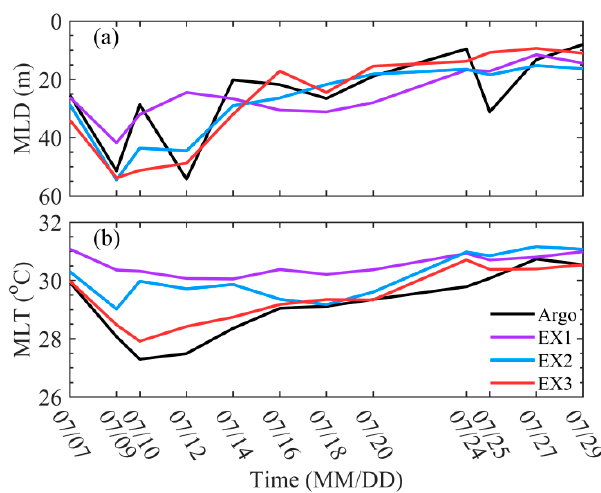
Figure 9. Plots of MLD (a) and MLT (b) derived from Argo data and numerical experiments at different times, during the processes of TC Nepartak. See Table 1 for the specification of the different experiments. Time is labeled when observation data is available.